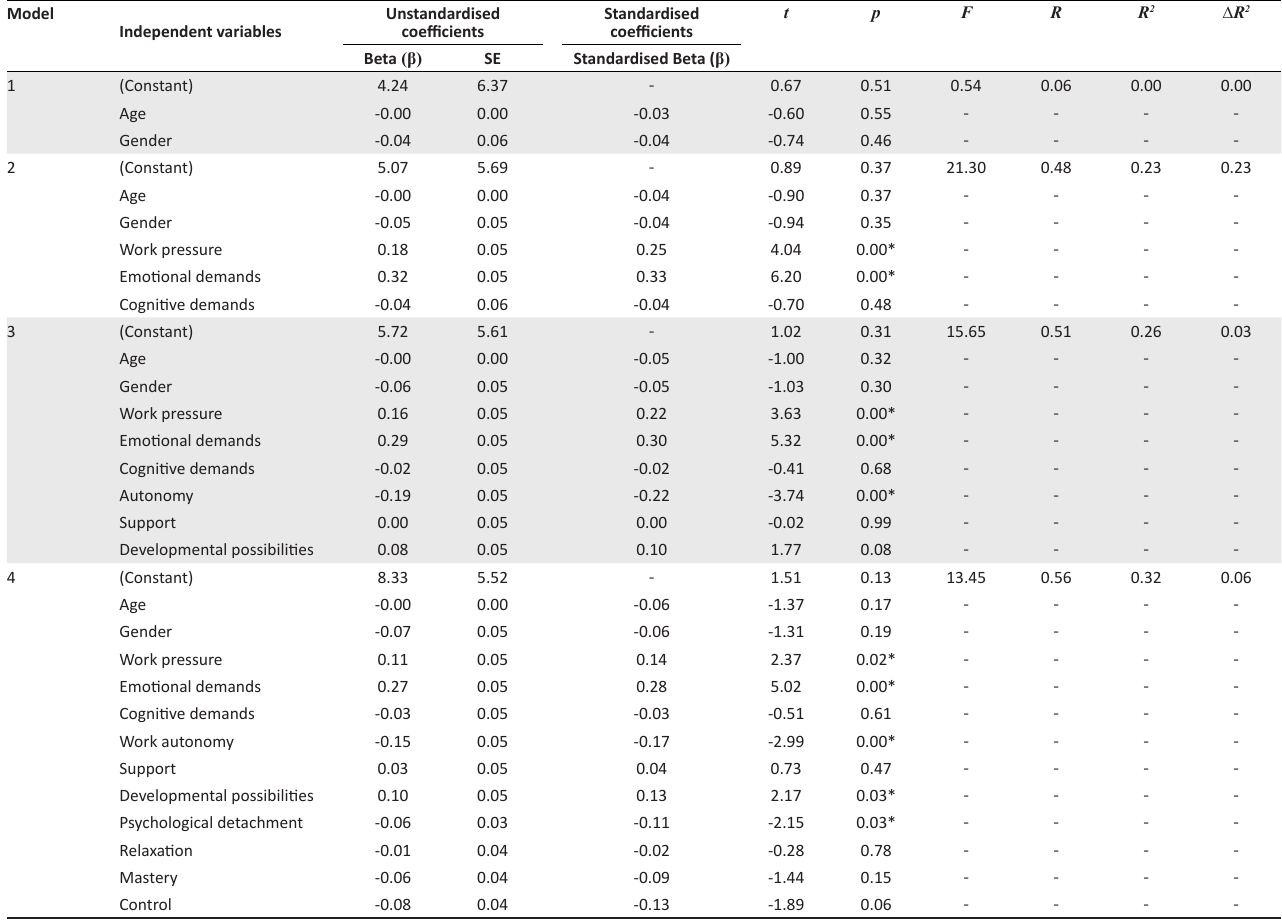
TABLE 5: Multiple regression analysis with work-religion and/or spirituality interference as dependent variable.